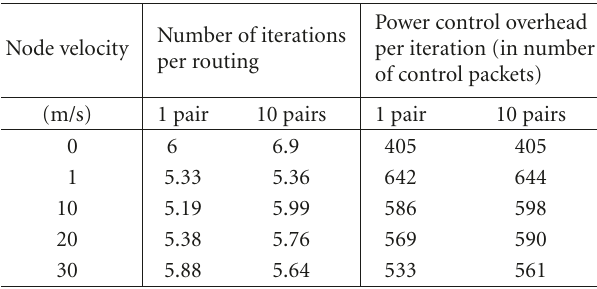
Table 3: Convergence and overhead of the proposed